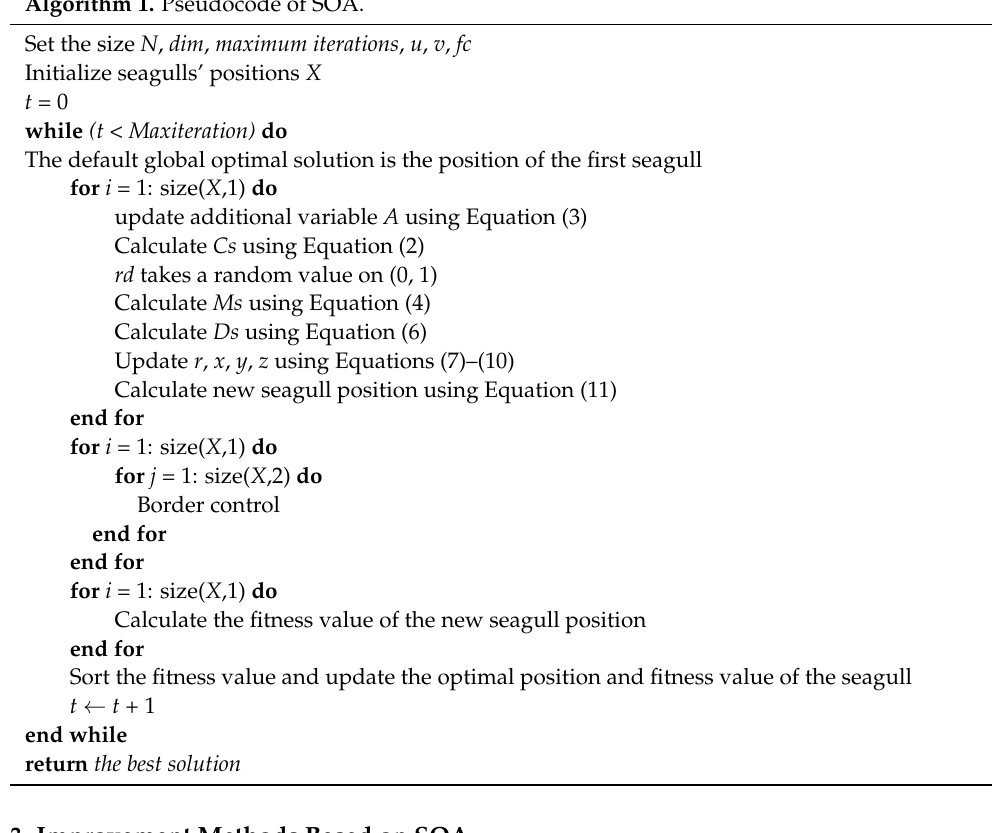
Algorithm 1. Pseudocode of